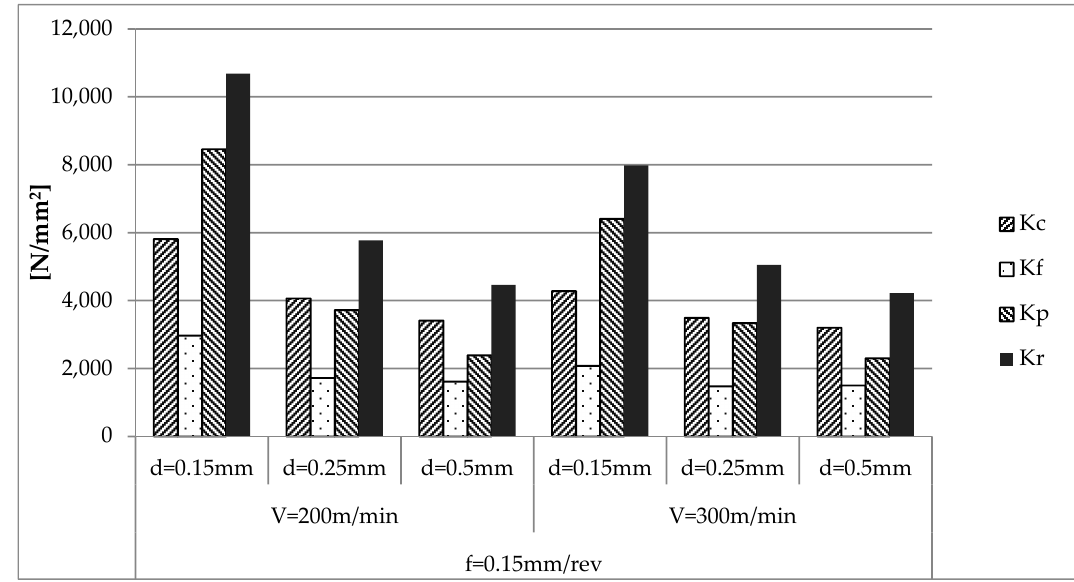
Figure 4. Initial specific cutting force components and specific resultant forces in turning tests with Seco’s PCBN tool.